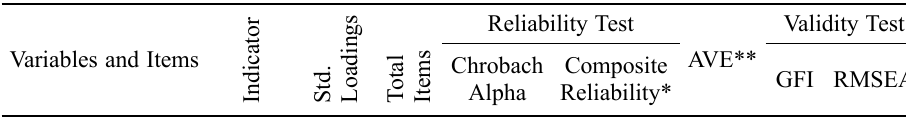
Table 1. Results of reliability and validity Test (n =